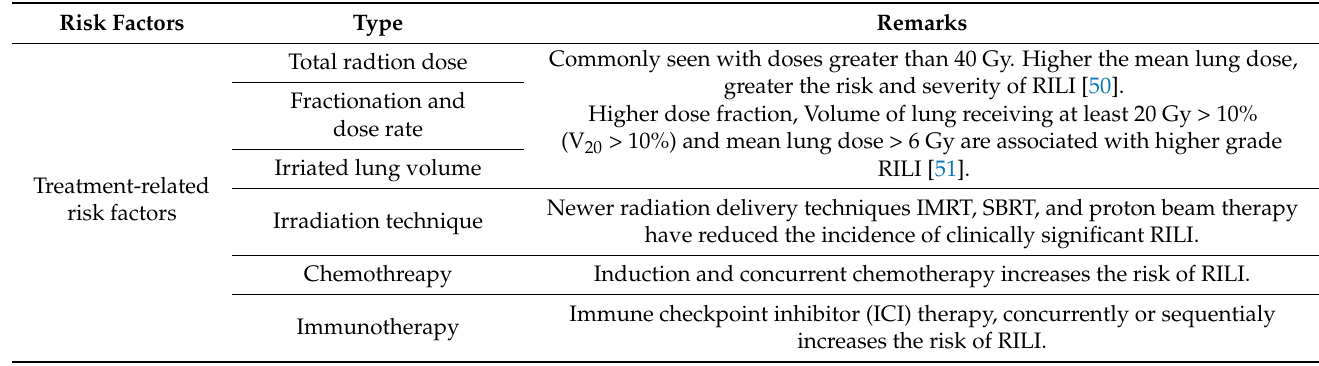
Table 1. Predisposing risk factors for radiation-induced lung